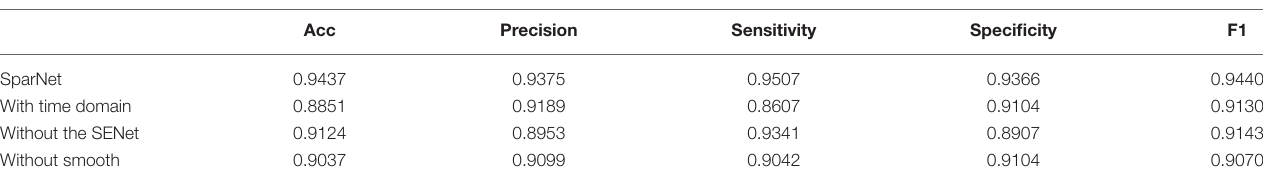
FIGURE 10 | Receiver Operating characteristic (ROC) curves and area of overall EEG data tests. TABLE 4 | Comparison of results before and after adding SENet module.